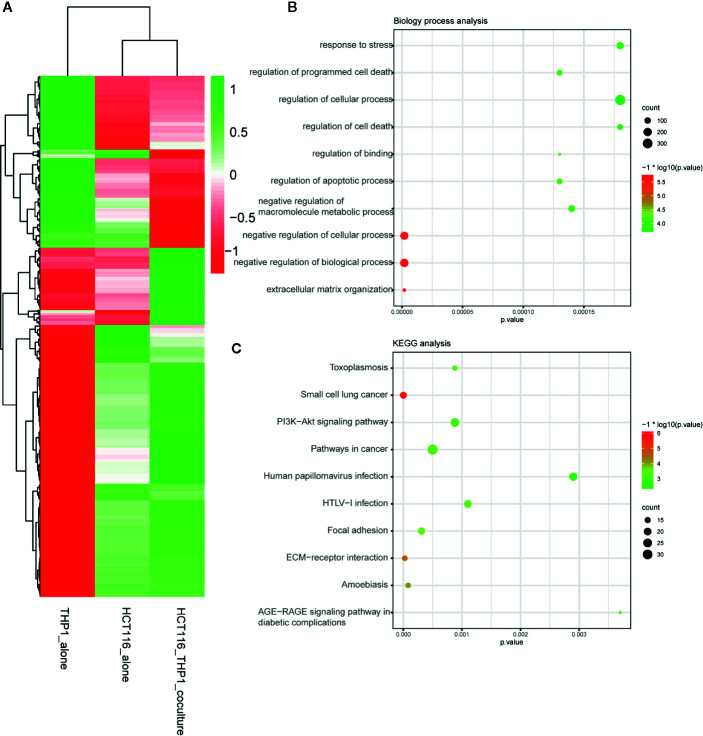
DEG identification after TAM treatment in CRC. (A) Demonstrated the increased and decreased genes after the integrated analysis. (B) GO analysis of DEG after TAM treatment in CRC. (C) KEGG analysis of DEG after TAM treatment in CRC.